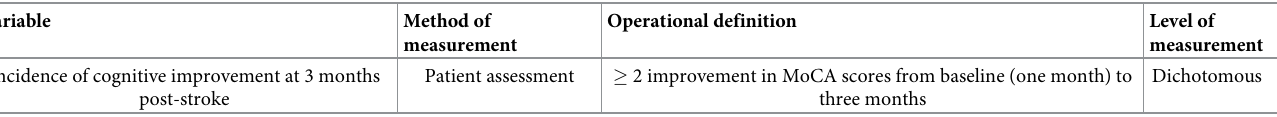
Table 2. Summary and description of objective number 1 variables of the study.